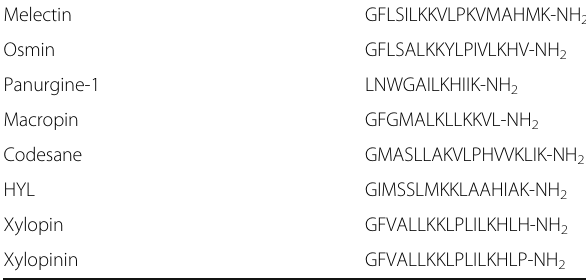
Table 1 Solitary bee venom peptides